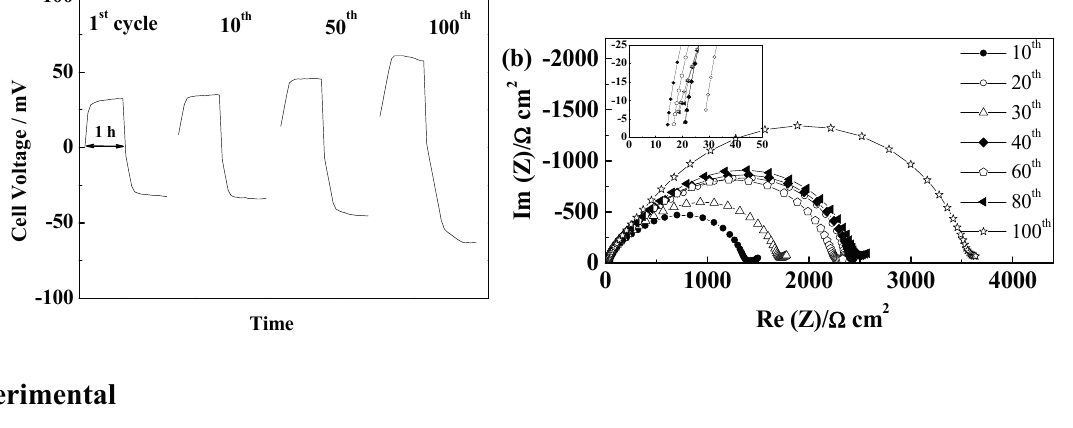
Figure 15. Evolution of a (Cellulose + PYR 0.1 mA·cm − 2 ( a ) Voltage profiles; and ( b ) Evolution of the impedance spectra at 20